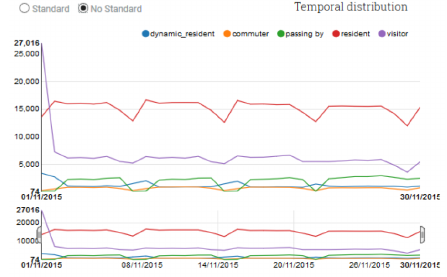
Figure 9. Temporal Distribution of presences in the municipality of